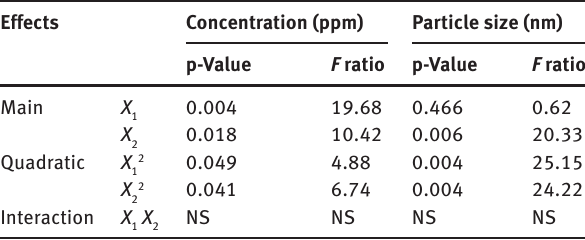
Table 3: p-Value and F ratio of the regression coefficients in the obtained models.